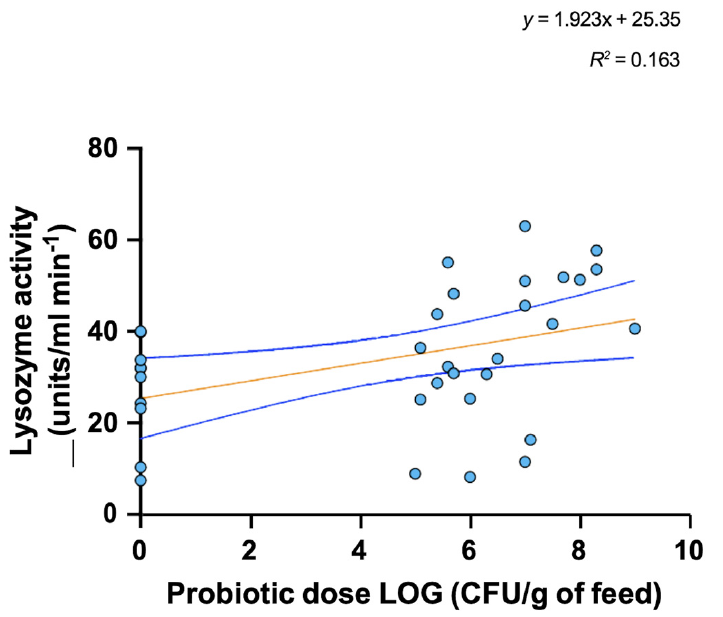
Figure 5. Data analysis revealed significant correlation between probiotic dose in feed and Lysozyme activity. Data analysis revealed no significant correlation between probiotic dose in feed and SGR in fish. The circles represent the mean of experimental groups (n = 3; either control group or probiotics treatment group) tested in the studies considered for the regression analysis.